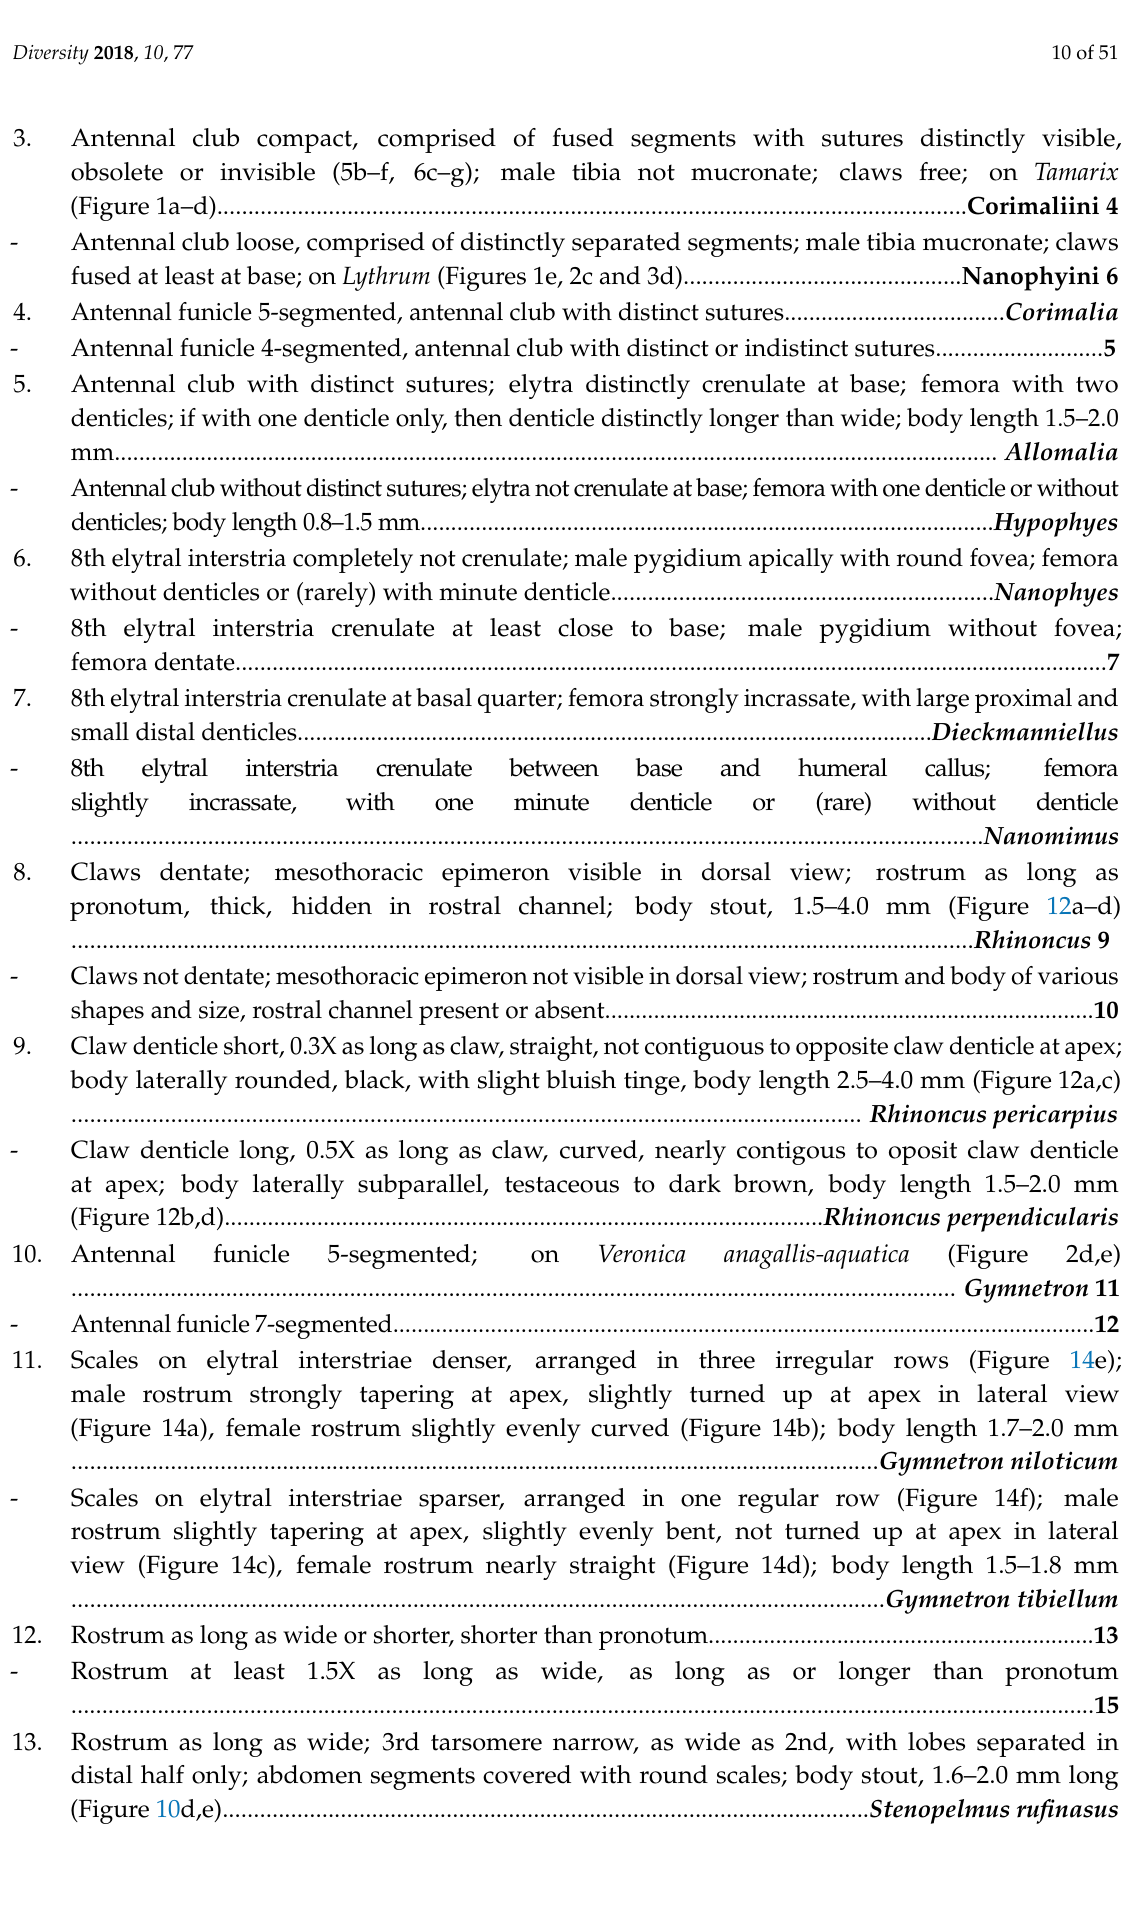
8. Claws dentate; mesothoracic epimeron visible in dorsal view; rostrum as long as pronotum, thick, hidden in rostral channel; body stout, 1.5–4.0 mm (Figure 12a–d) - Claws not dentate; mesothoracic epimeron not visible in dorsal view; rostrum and body of various shapes and size, rostral channel present or absent................................................................................ 10 9. Claw denticle short, 0.3X as long as claw, straight, not contiguous to opposite claw denticle at apex; body laterally rounded, black, with slight bluish tinge, body length 2.5–4.0 mm (Figure 12a,c) - Claw denticle long, 0.5X as long as claw, curved, nearly contigous to oposit claw denticle at apex; body laterally subparallel, testaceous to dark brown, body length 1.5–2.0 mm 10. (Figure 2d,e) - 11. Scales on elytral interstriae denser, arranged in three irregular rows (Figure 14e); male rostrum strongly tapering at apex, slightly turned up at apex in lateral view (Figure 14a), female rostrum slightly evenly curved (Figure 14b); body length 1.7–2.0 mm - Scales on elytral interstriae sparser, arranged in one regular row (Figure 14f); male rostrum slightly tapering at apex, slightly evenly bent, not turned up at apex in lateral view (Figure 14c), female rostrum nearly straight (Figure 14d); body length 1.5–1.8 mm 12. - Rostrum at least 1.5X as long as wide, as long as or longer than pronotum 13. Rostrum as long as wide; 3rd tarsomere narrow, as wide as 2nd, with lobes separated in distal half only; abdomen segments covered with round scales; body stout, 1.6–2.0 mm long (Figure 10d,e)........................................................................................................ Stenopelmus